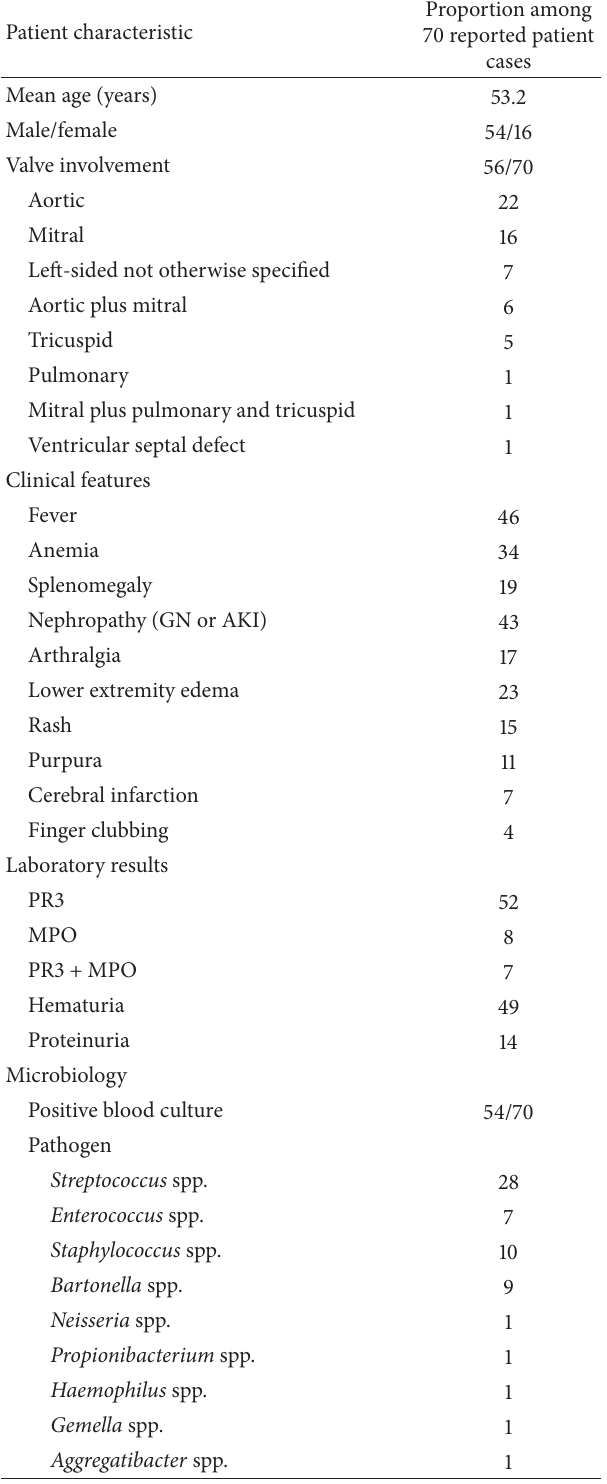
Table 1: Number of positive clinical and laboratory characteristics among all previously reported cases of ANCA-positive infective endocarditis ∗